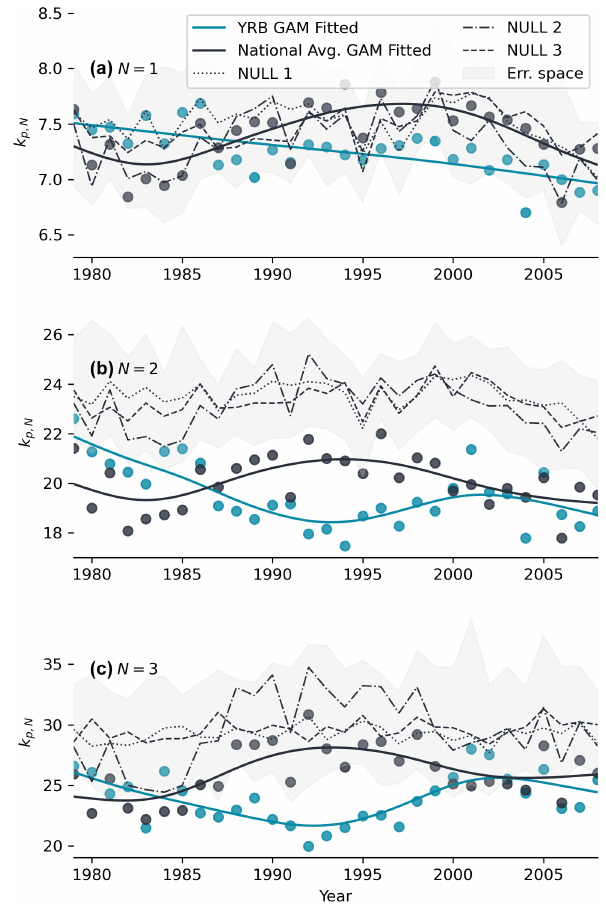
Figure 4. Trends of different dimensions based on the reflecting method decomposed from complexity (see Sect. 2.3 and Table 1). Blue and grey colours show the average levels of the YRB and China, respectively. (a) N = 1, number of major crops that support virtual water outflow (VWF), an indication of diversification of a certain region. (b) N = 2, the total number of provinces where sim- ilar dominant crops supporting VWF are included, a smaller number indicating the greater uniqueness of the particular region. (c) N = 3, the total number of dominant crop types supporting VWF from all competitors (who have similar dominant crops). A smaller number of competitors means higher competitiveness of the